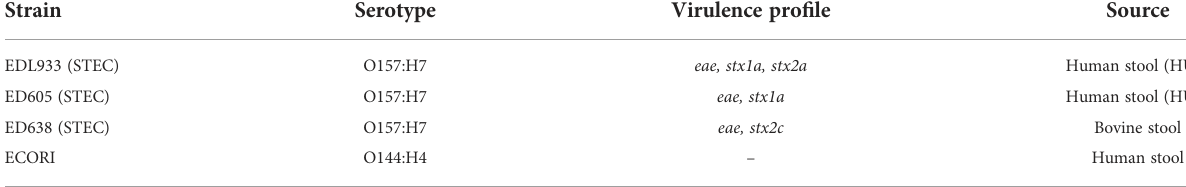
TABLE 1 Characteristics of bacterial strains used in this